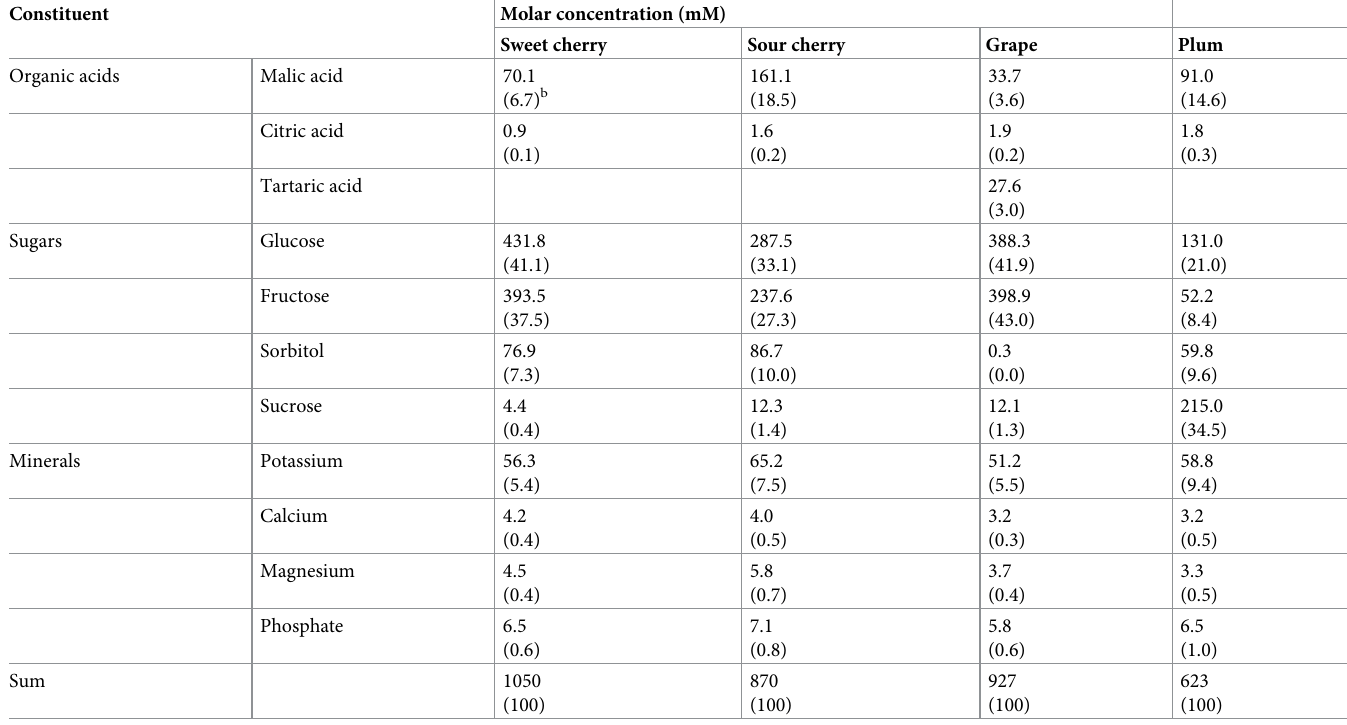
Table 2. Molar concentrations of abundant osmolytes in sweet and sour cherry, grape and plum a at